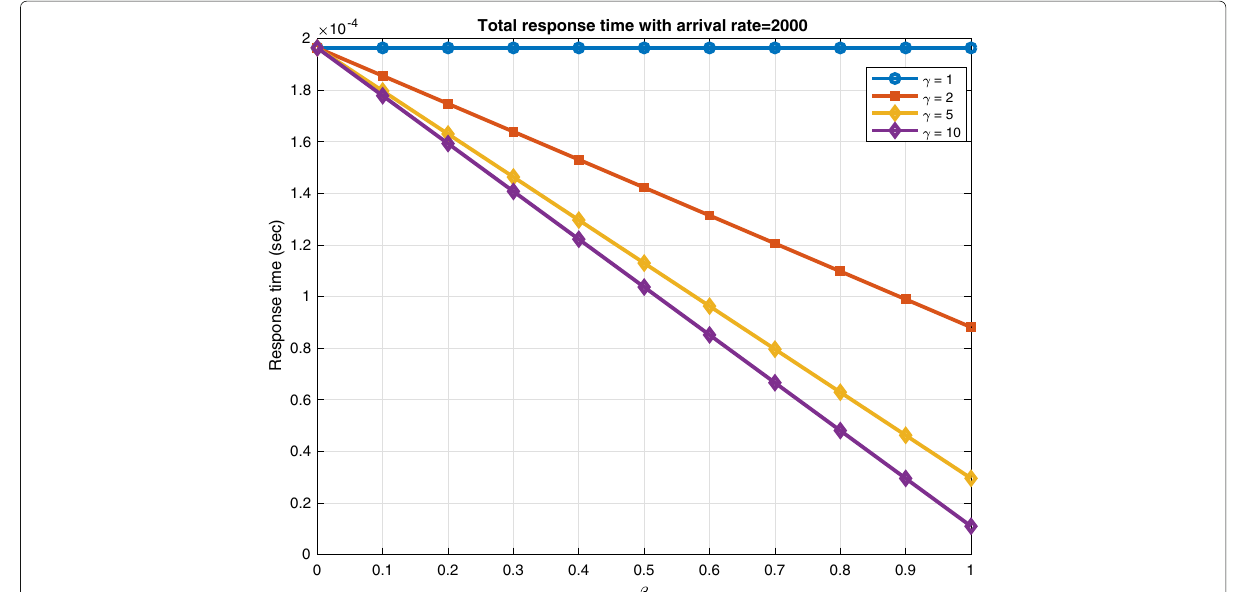
Fig. 7 Total response time vs. probability distribution while pre-fetcher’s processor speed multiplier is changing. γ = 1, γ = 2, γ = 3, γ =